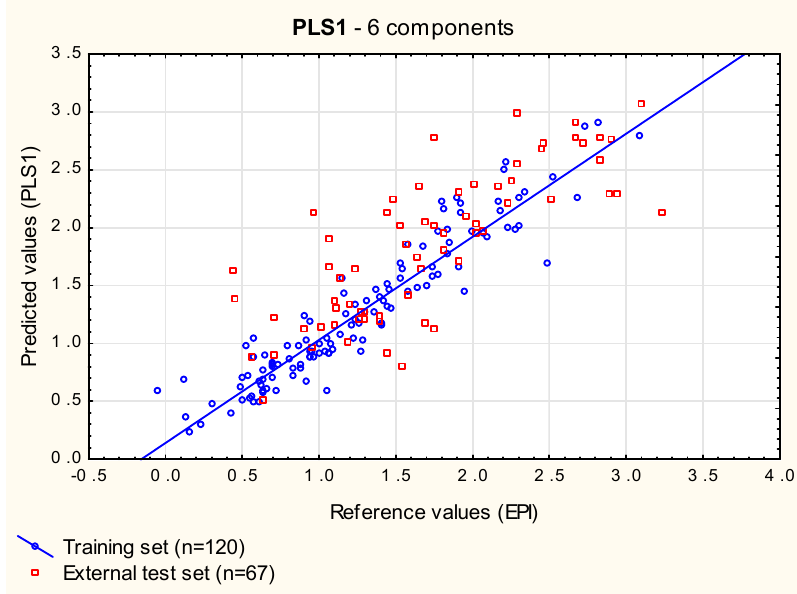
Figure 4. PLS1 model (six components)—predicted vs. reference log BCF values.